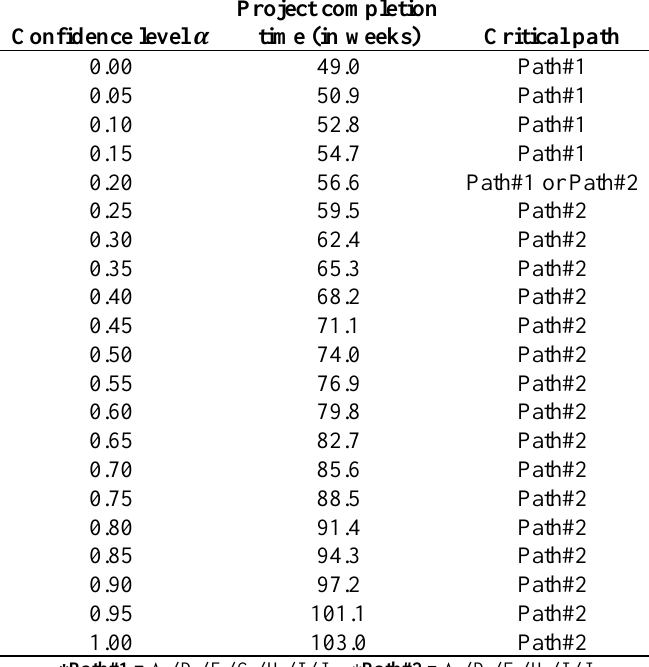
Table 2. Project completion times for different confidence levels